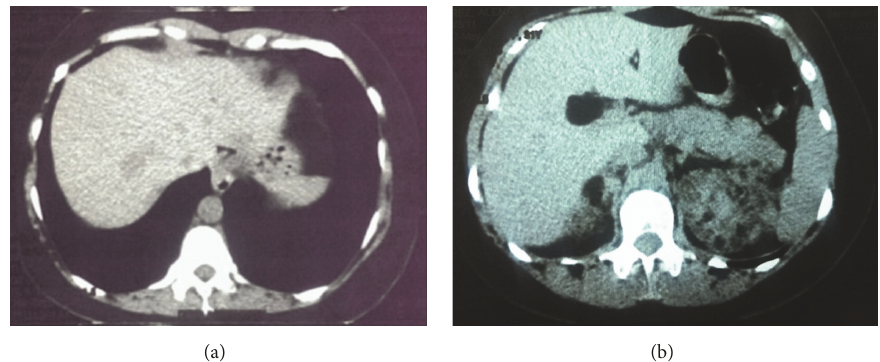
Figure 2: (a) CT cut from the abdomen showing multiple hypodense lesions in the liver with the largest lesion in the right lobe. (b) Lower cut showing multiple angiomyolipomas in the upper pole of the right and left kidney, which have interrupted the normal size, shape, and density of the organ. The Hounsfield values of the lesions are similar to that of the subdermal fat tissue.